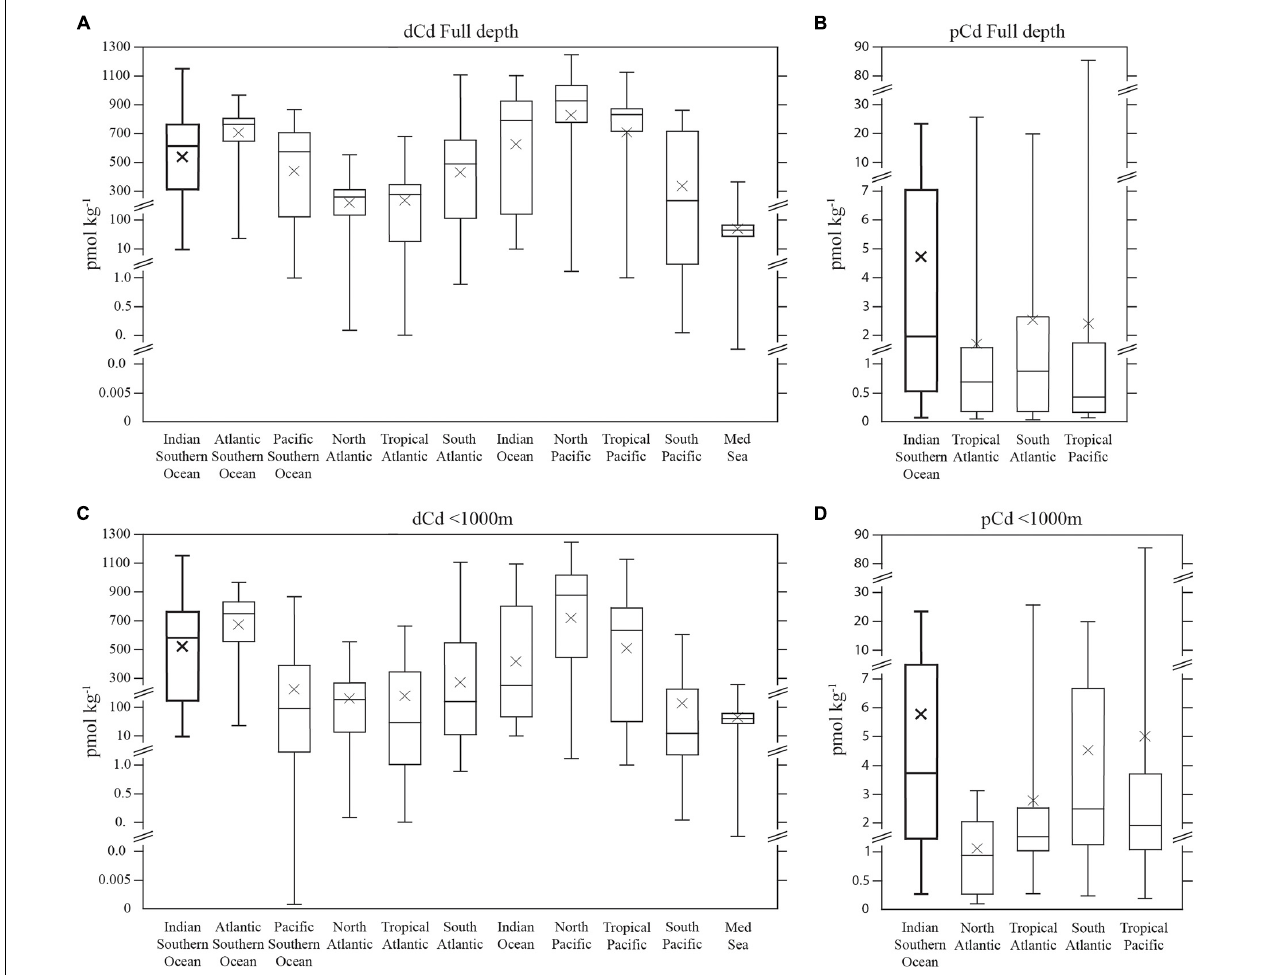
FIGURE 3 | Box and whisker plots of (A) dCd for full depth profiles, (B) pCd for full depth profiles, (C) dCd for profiles to 1,000 m and (D) pCd for profiles to 1,000 m. Data compiled from all available data from the GEOTRACES intermediate data product (IDP) 2017 (Schlitzer et al., 2018). Plots in bold are data from this study. From bottom to top, plots are structured as follows: minimum, quartile 1, median, quartile 3, maximum. The cross ( x ) represents the mean value. Note the changes in the vertical scale. For dCd data references are as follows, Indian Southern Ocean data [this study ( n = 132 full depth; 103 < 1,000 m)], Atlantic Southern Ocean [transect GIPY05 ( n = 177 full depth; 116 < 1,000 m) (Baars et al., 2014)], Pacific Southern Ocean [transect GIPY06 ( n = 82 full depth; 223 < 1,000 m) (Butler et al., 2013), transect GIPY02 ( n = 0 full depth; 109 < 1,000 m) (Butler et al., 2013), transect GPpr01 ( n = 0 full depth; 34 < 1,000 m) (Hassler and Ellwood, unpublished), transect GPpr02 ( n = 77 full depth; 168 < 1,000 m (Ellwood, 2008)], North Atlantic Ocean [transect GA02 ( n = 407 full depth; 227 < 1,000 m) (Middag et al., 2018), transect GA03 ( n = 588 full depth; 303 < 1,000 m) (Hayes et al., 2018)], Tropical Atlantic Ocean [transect GA02 ( n = 479 full depth; 259 < 1,000